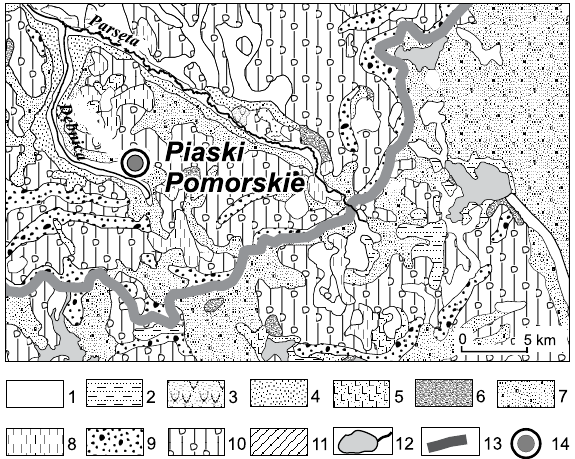
Fig. 3. lithology of surface sediments of the research